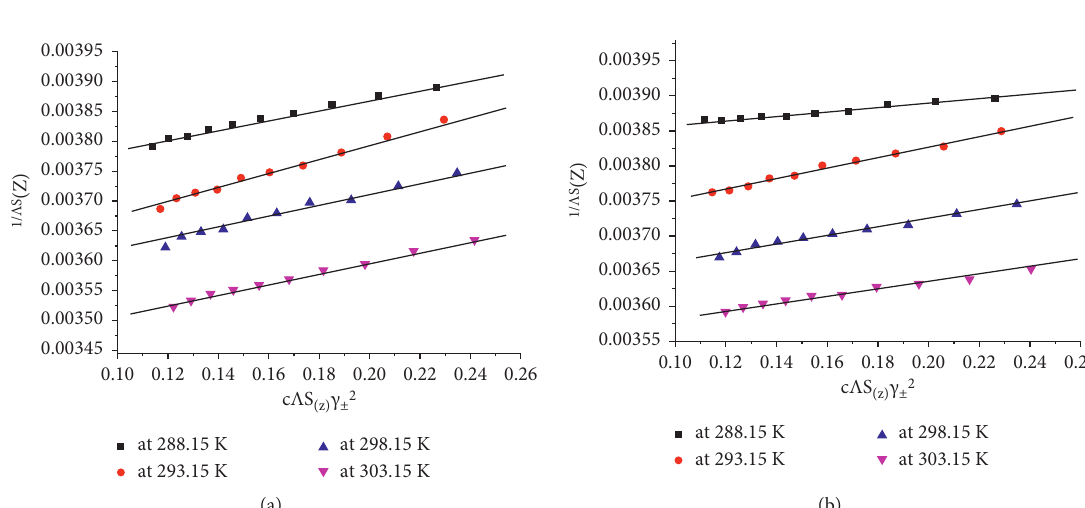
Figure 6: Variation of the molar conductance, l/ Λ S at (288.15, 293.15, 298.15, and 303.15)